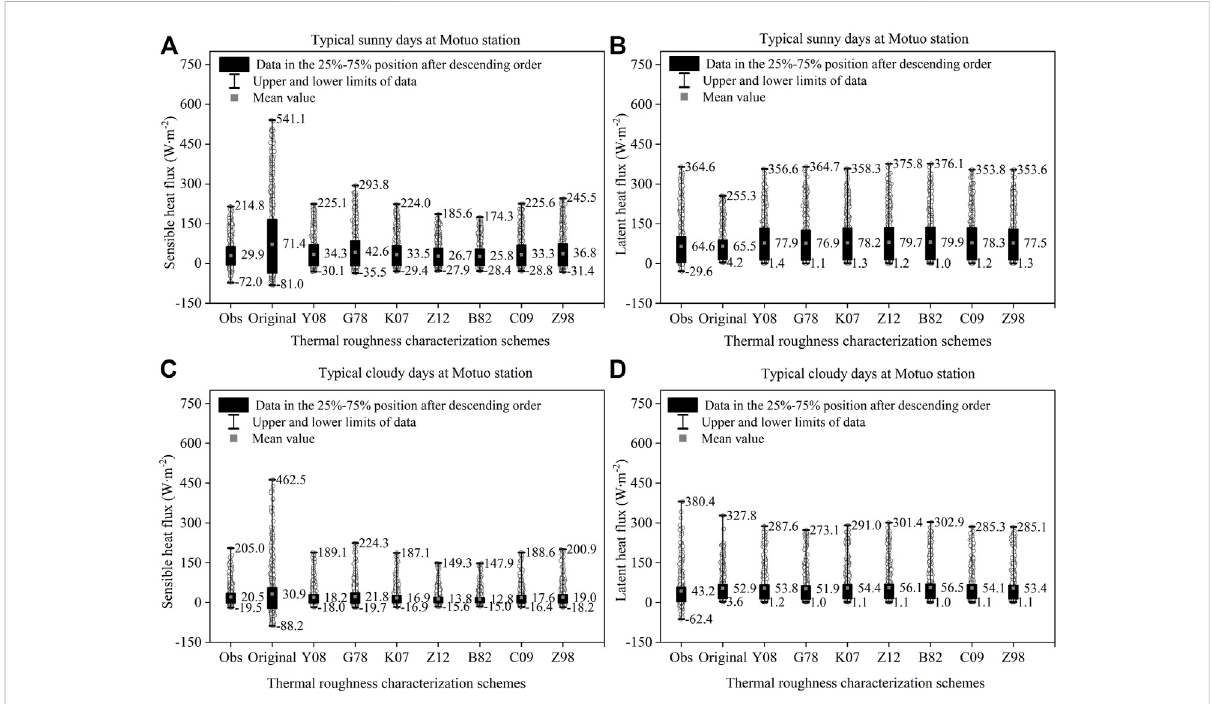
FIGURE 7 Boxplotsof the observations and thesimulationsof H and LE under different Z 0h schemes on typical sunny/cloudy days at Motuo station, (A and C) H, (B and D) ) LE, unit: (W · m − 2